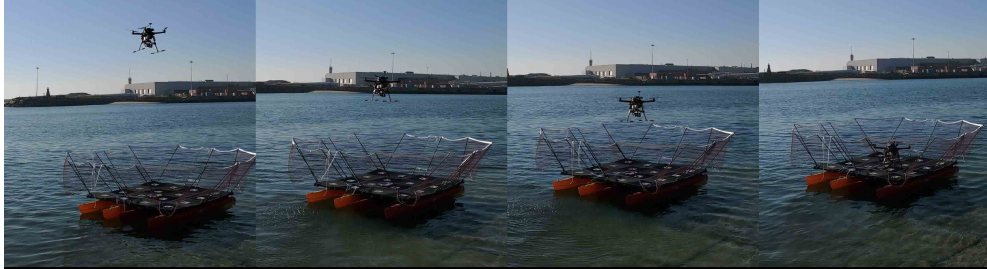
Figure 6. The conducted real experiment of a landing procedure using the CROW